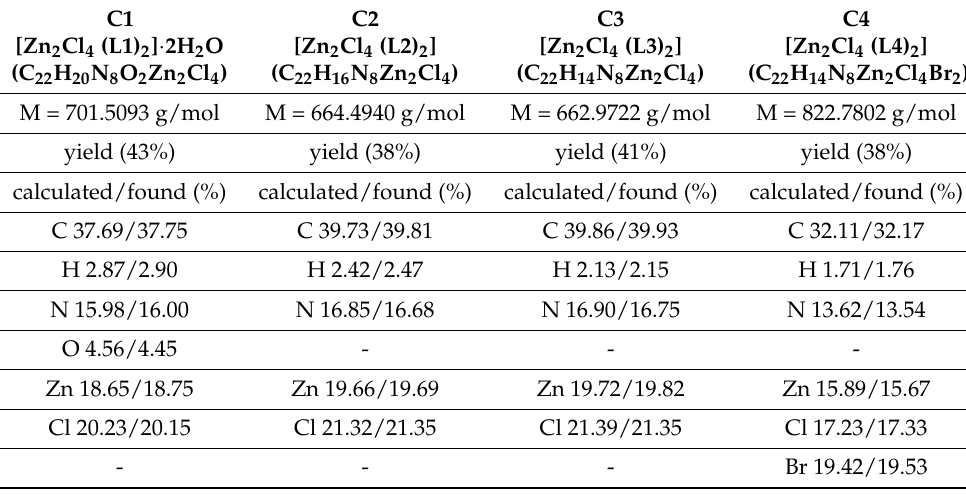
Table 1. Percentage composition of the elements in coordination